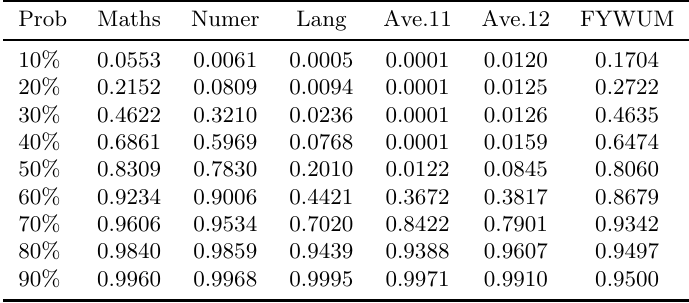
Table 1: Test Battery 2 variables of 1999 intake group: Cumulative probabilities calculated by numerical